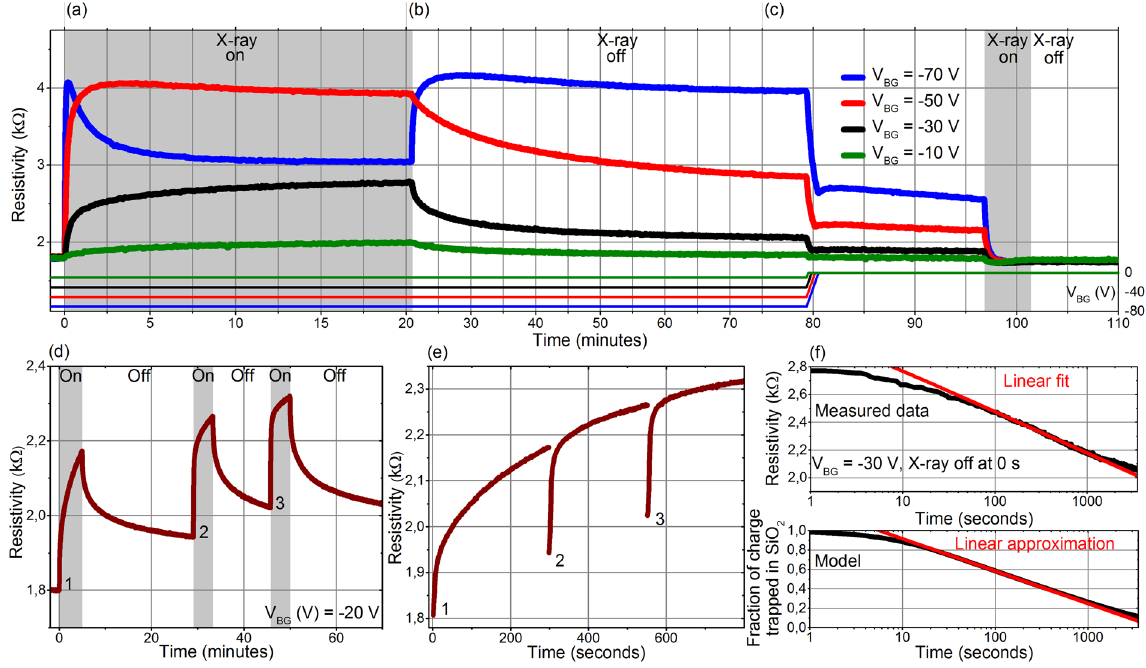
Figure 3. Time traces recorded during succeeding X-ray irradiation and relaxation of the GFETs. ( a–c ) Full time traces showing long ( a ) X-ray irradiation, ( b ) relaxation, and ( c ) erasing. ( d ) Three succeeding X-ray irradiations interrupted with periods of relaxation while keeping the set V BG = − 20 V. ( e ) The time trace given in ( d ) with excluded relaxation periods. ( f ) Measured resistivity (top) and calculated trapped charge (bottom) relaxations in logarithmic time